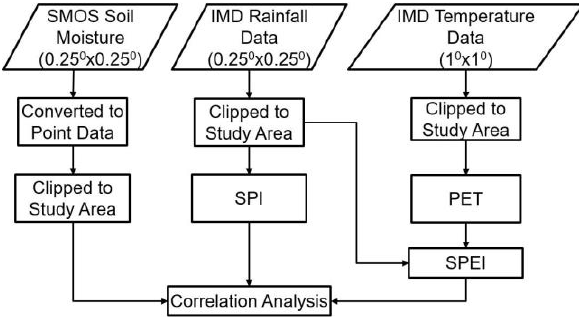
Figure 2. Methodology for drought assessment using SMOS and IMD rainfall and temperature